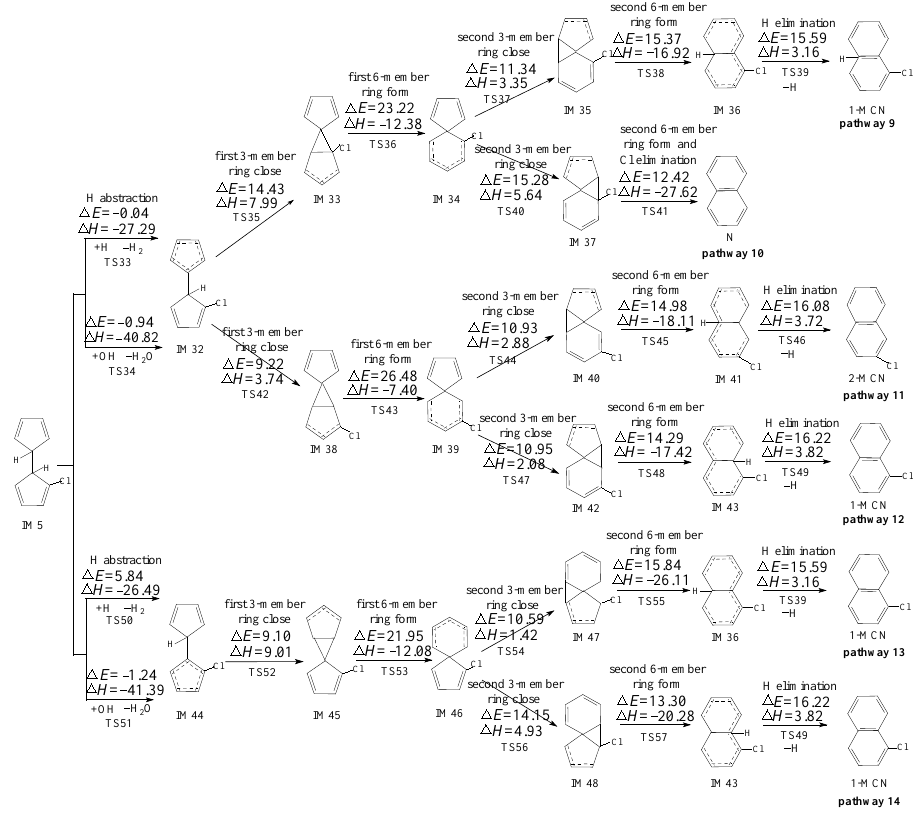
Figure 3. PCN formation routes embedded with the potential barriers Δ E (in kcal/mol) and reaction heats Δ H (in kcal/mol) from IM5. Δ H is calculated at 0 K.